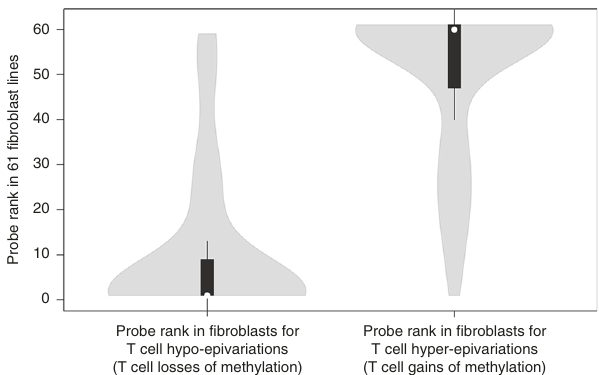
Fig. 6 Epivariations detected in blood cells are conserved in fi broblasts from the same individual. The presence of outlier methylation changes in T cells is strongly correlated with outlier methylation in fi broblasts from the same individual (Spearman rank correlation 0.75, p = 1.2 × 10 − 27 , Wilcoxon Rank-Sum test). White dots show the median; box limits indicate the 25th and 75th percentiles; whiskers extend 1.5 times the interquartile range